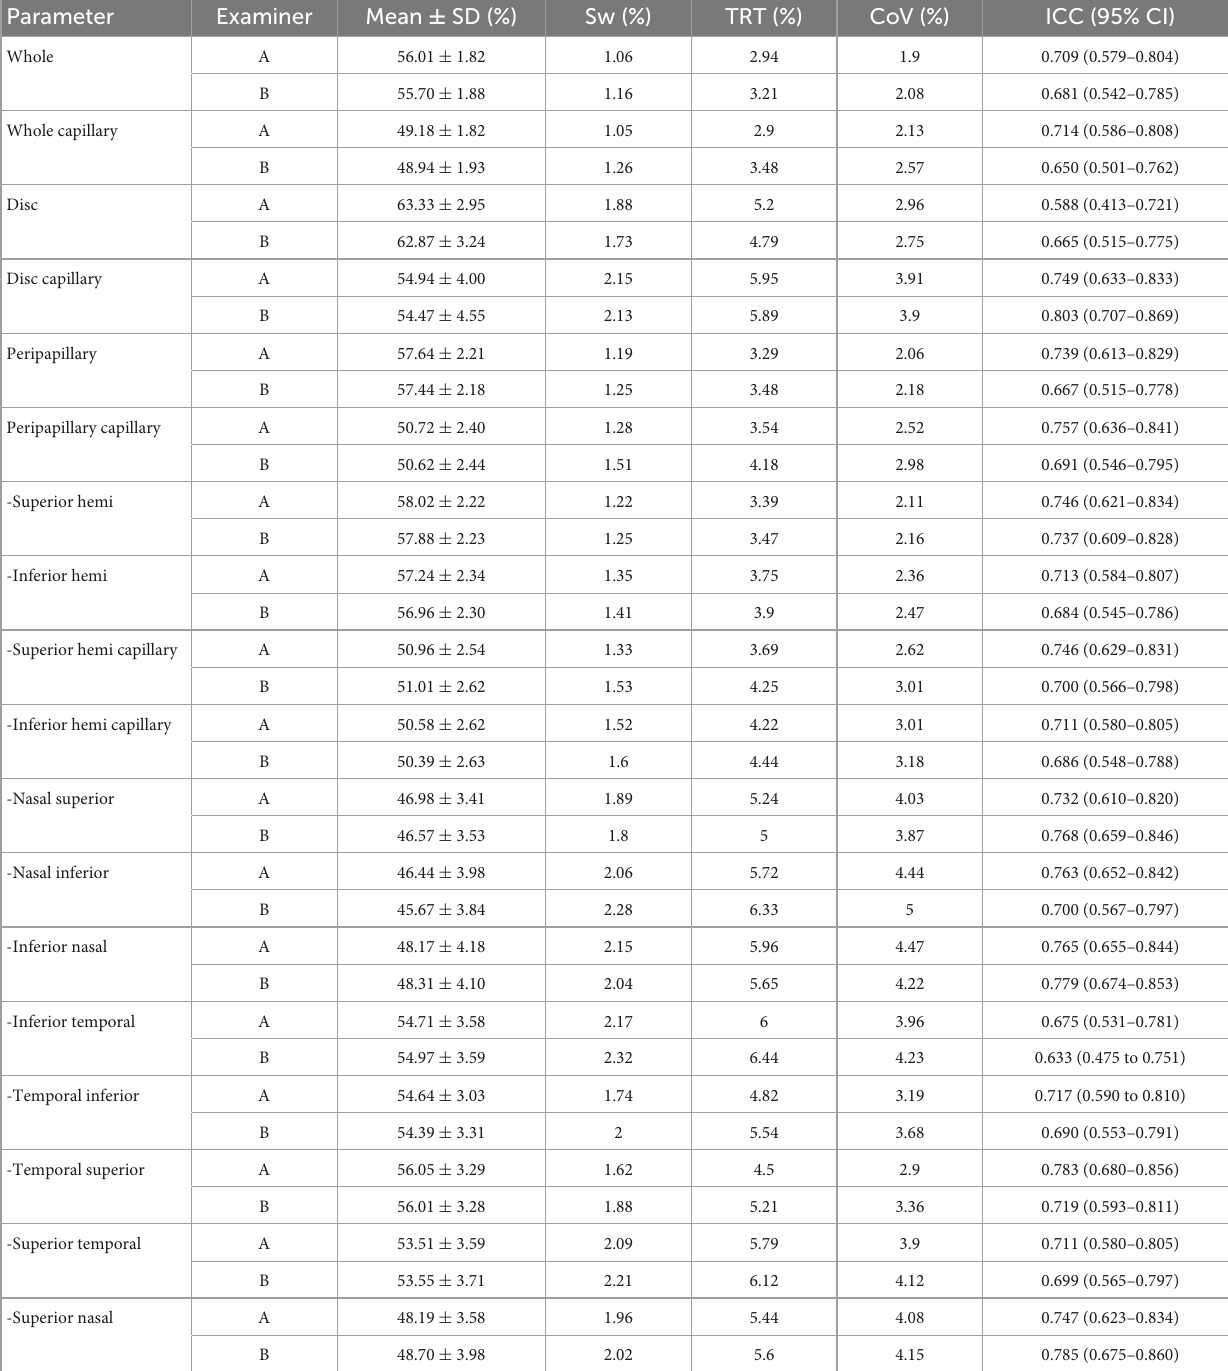
TABLE 1 Intra-examiner repeatability of the OCTA in measuring the papillary and peripapillary vascular density.